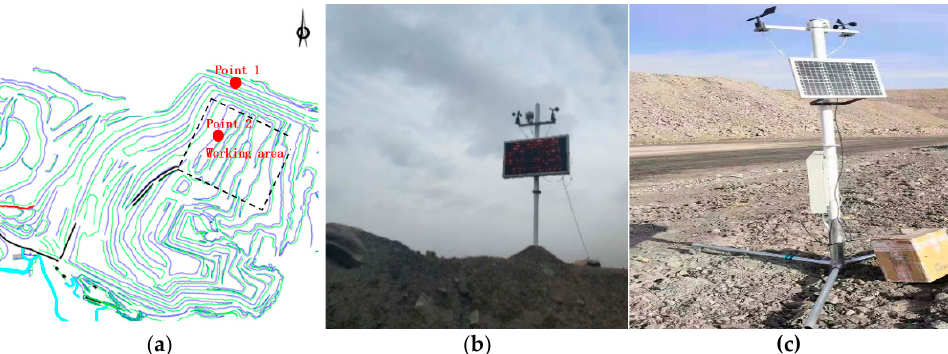
Figure 1. Schematic diagram of equipment location, ( a ) Location of measuring point; ( b ) Measuring point 1; ( c ) Measuring point 2.